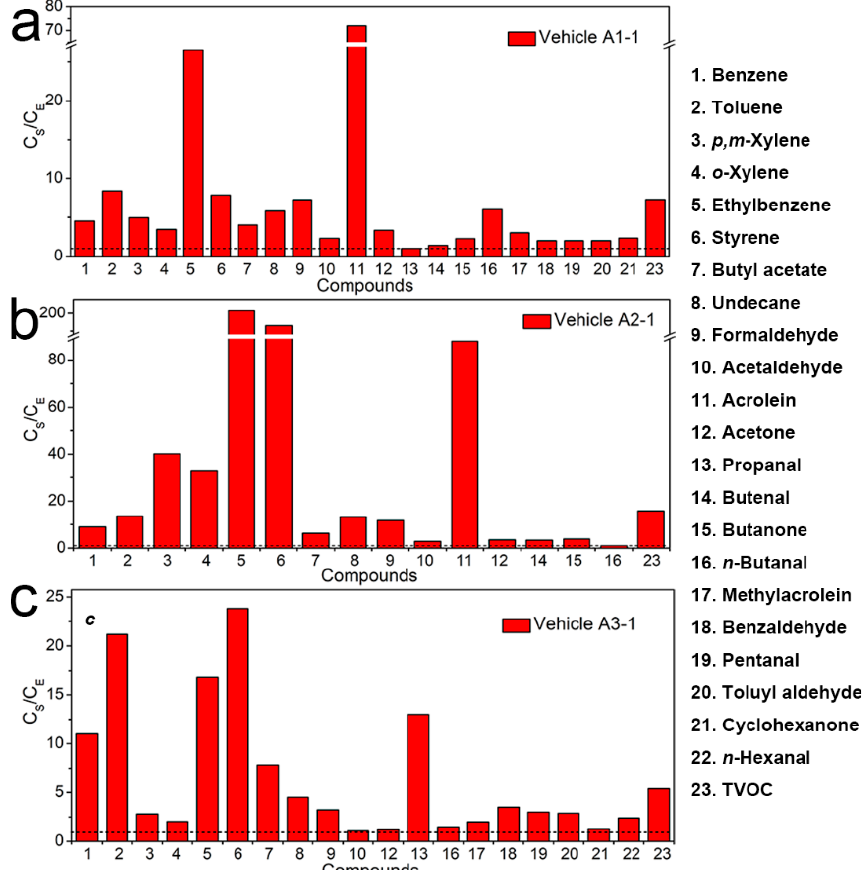
Figure 2. The ratios of concentrations of confirmed compounds and TVOC measured inside the ( a ) Vehicle A1-1, ( b ) Vehicle A2-1, ( c ) Vehicle A3-1 in sunshine condition (C S ) to that in the environment test chamber (C E ). The black short dash corresponds to a value of 1.